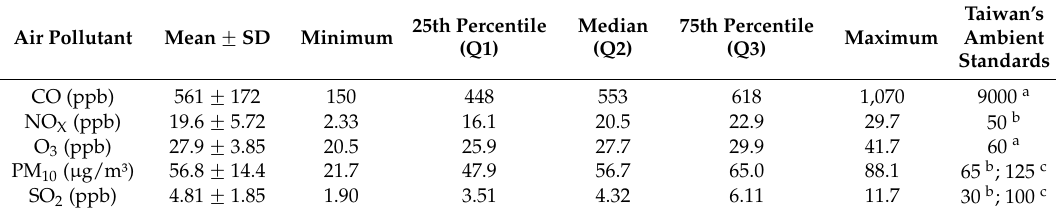
Table 2. Descriptive statistics of daily concentrations of air pollutants for 2006–2011 in